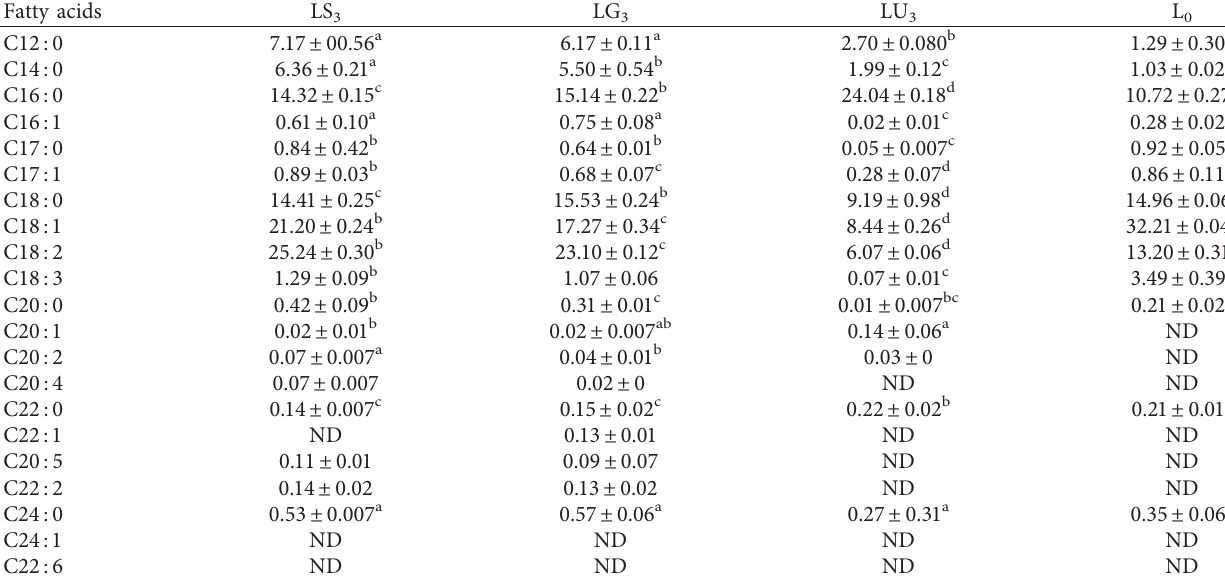
Table 6: Fatty acid profile of fruit paste samples with 1.5% algae powder. Fatty